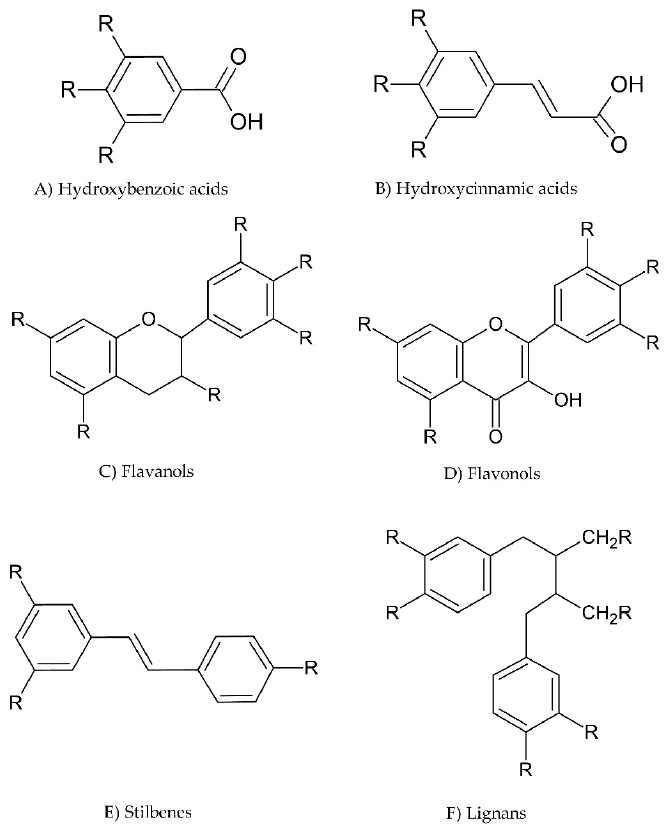
Figure 3. Catechins are common flavanols that have all their functional groups as hydroxyl groups, as shown in Figure 3C. Phenolic acids are divided into two subgroups; hydrox- ybenzoic acids and hydroxycinnamic acids (Figure 3A,B). For example, if the functional groups in hydroxybenzoic acid are all hydroxyl groups, then we would have a gallic acid structure, while, in hydroxycinnamic acids, if only one functional group is present as a hydroxyl group, a coumaric acid is formed; however, if two functional groups are present as hydroxyl groups, then we would obtain caffeic acid.